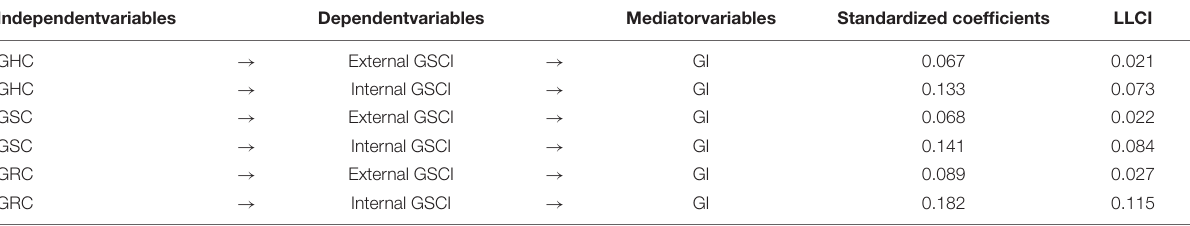
TABLE 5 | Results of the analysis (mediation effects).